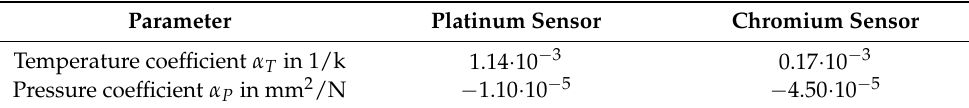
Table 2. Temperature and pressure coefficients of the considered thin-film sensors.